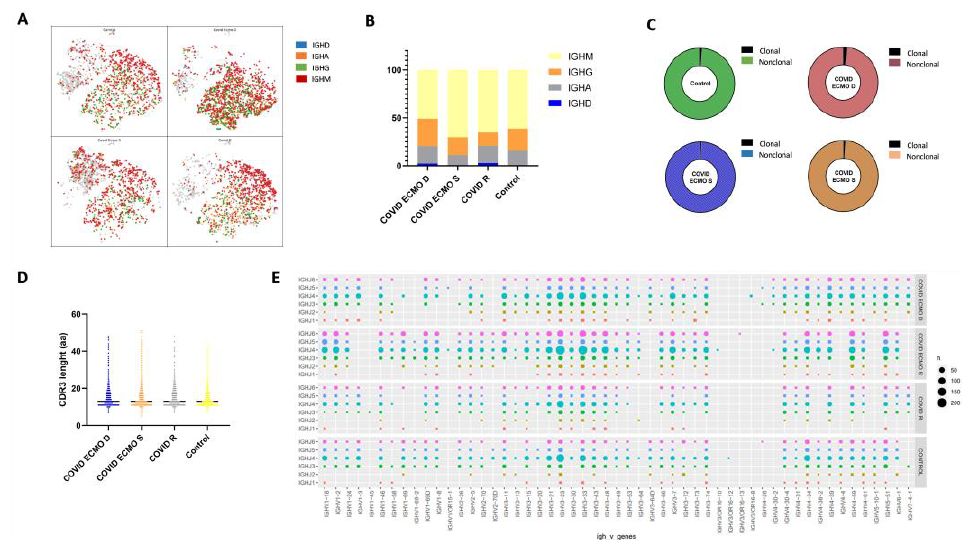
Figure 4. ( A ) t-SNE plot of B cells colored by immunoglobulin heavy chain expression. ( B ) The pro- portion of different immunoglobulin isotypes in each sample. ( C ) The pie plot shows the proportion of clonally expanded B cells in the COVID ECMO S, COVID ECMO D, and COVID R patients and in the healthy control. ( D ) The distribution of immunoglobulin heavy chain (IGH) CDR3 length. ( E ) The bubble chart shows the usage frequency of V–J gene combination in each sample.